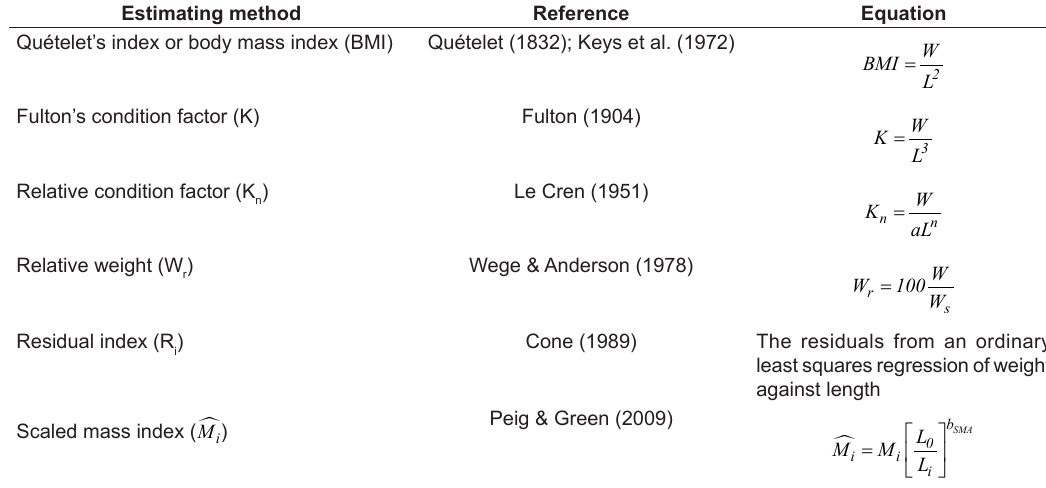
Table 1. Methods used to estimate the condition factor and their respective references and equations that were identi- fied in the papers that cited ‘Le Cren, 1951’ based on a search from 1951 to December 2015. Estimating method